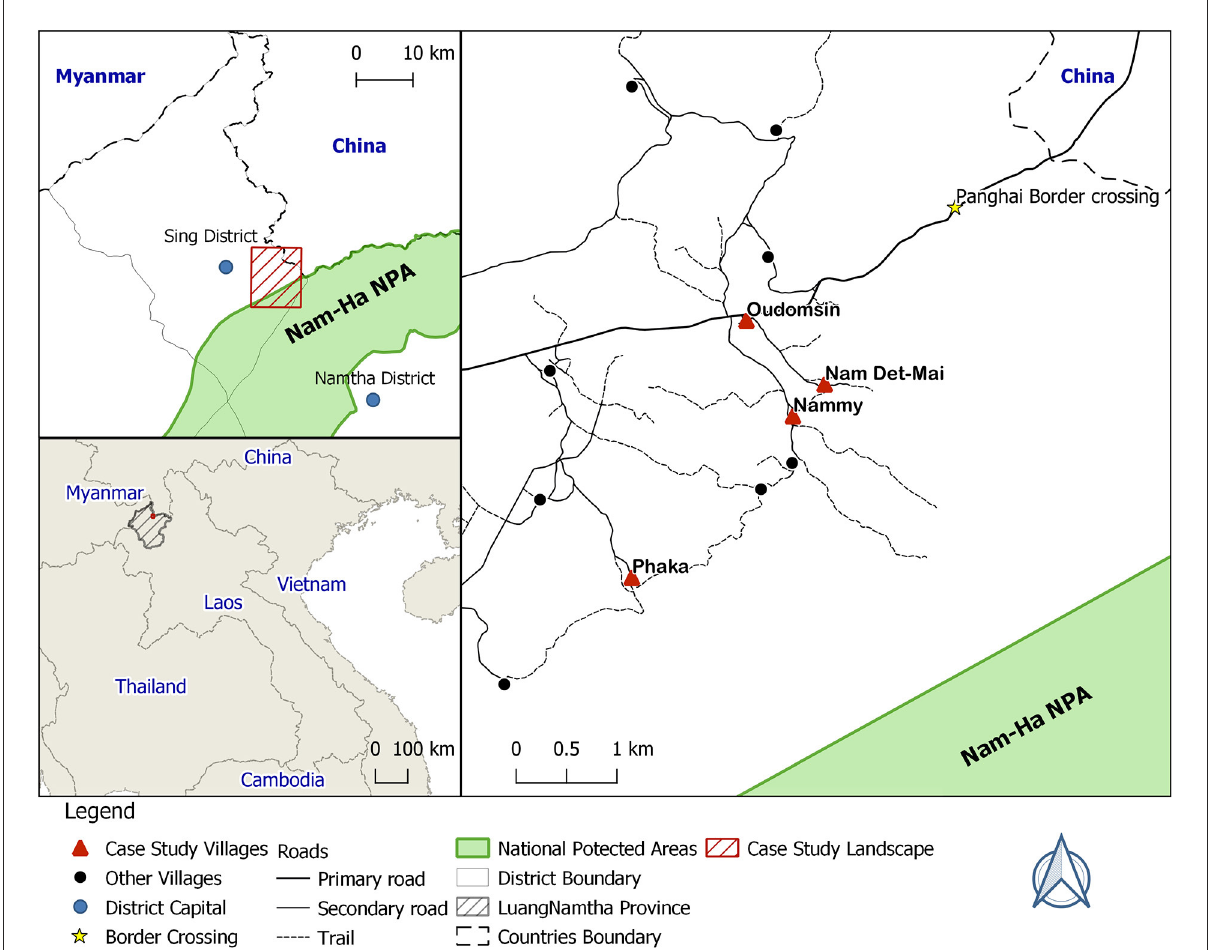
FIGURE1 Overview of the case-study landscape in the Sing district, Luang Namtha province, northwestern Laos. NPA, National Protected Area.